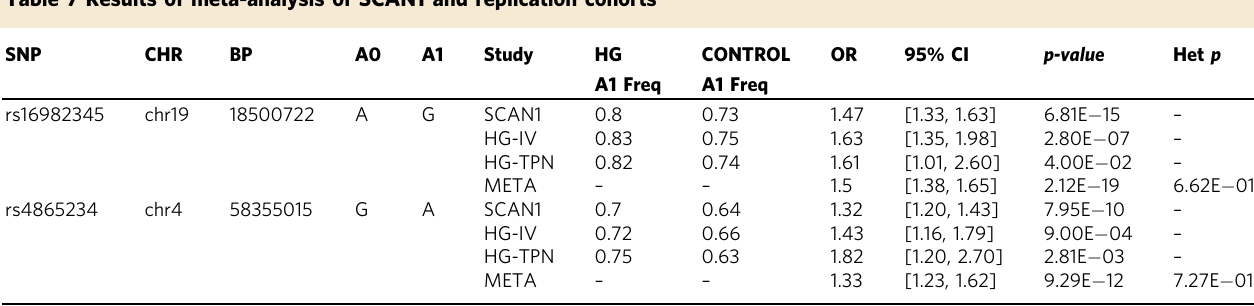
Table 7 Results of meta-analysis of SCAN1 and replication cohorts SNP CHR